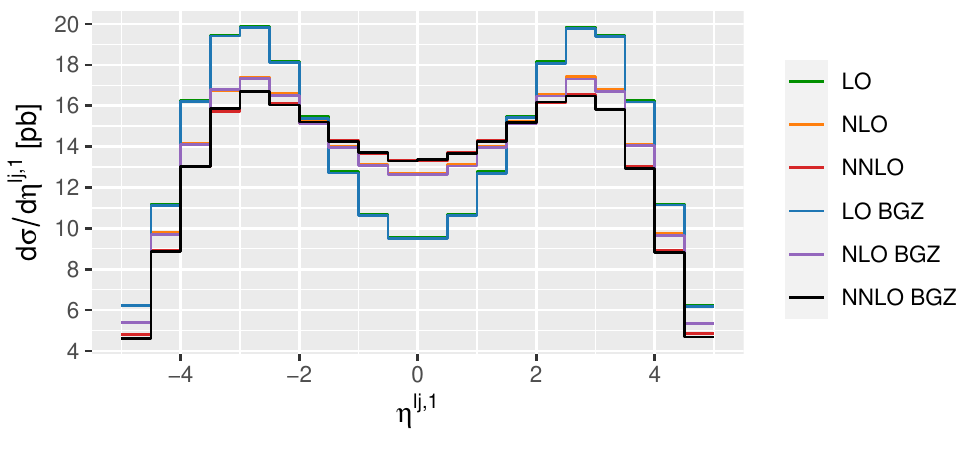
Figure 9 . Leading jet pseudorapidity distribution in stable top-quark production at LO , NLO and NNLO using NNLO CT14 PDF s. Our cross sections are compared with the results in ref. [38] ( BGZ ).